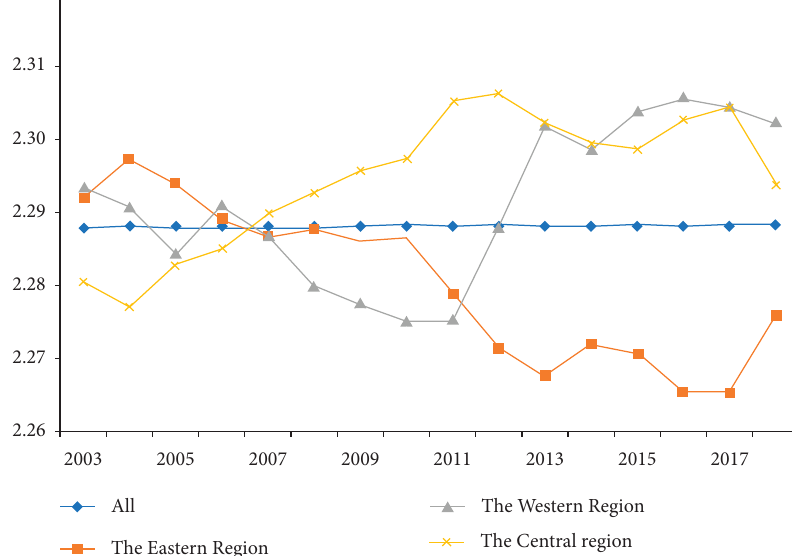
Figure 4: Comparison of efciency loss of construction investment of diferent regions in China caused by the agency